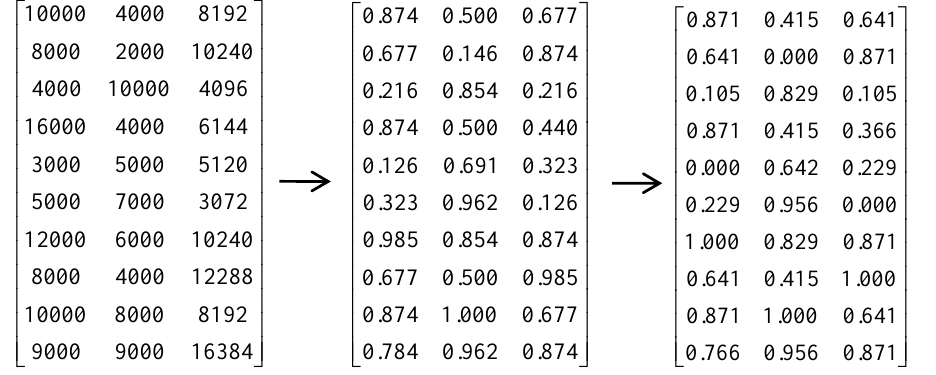
Figure 4. Process of data.